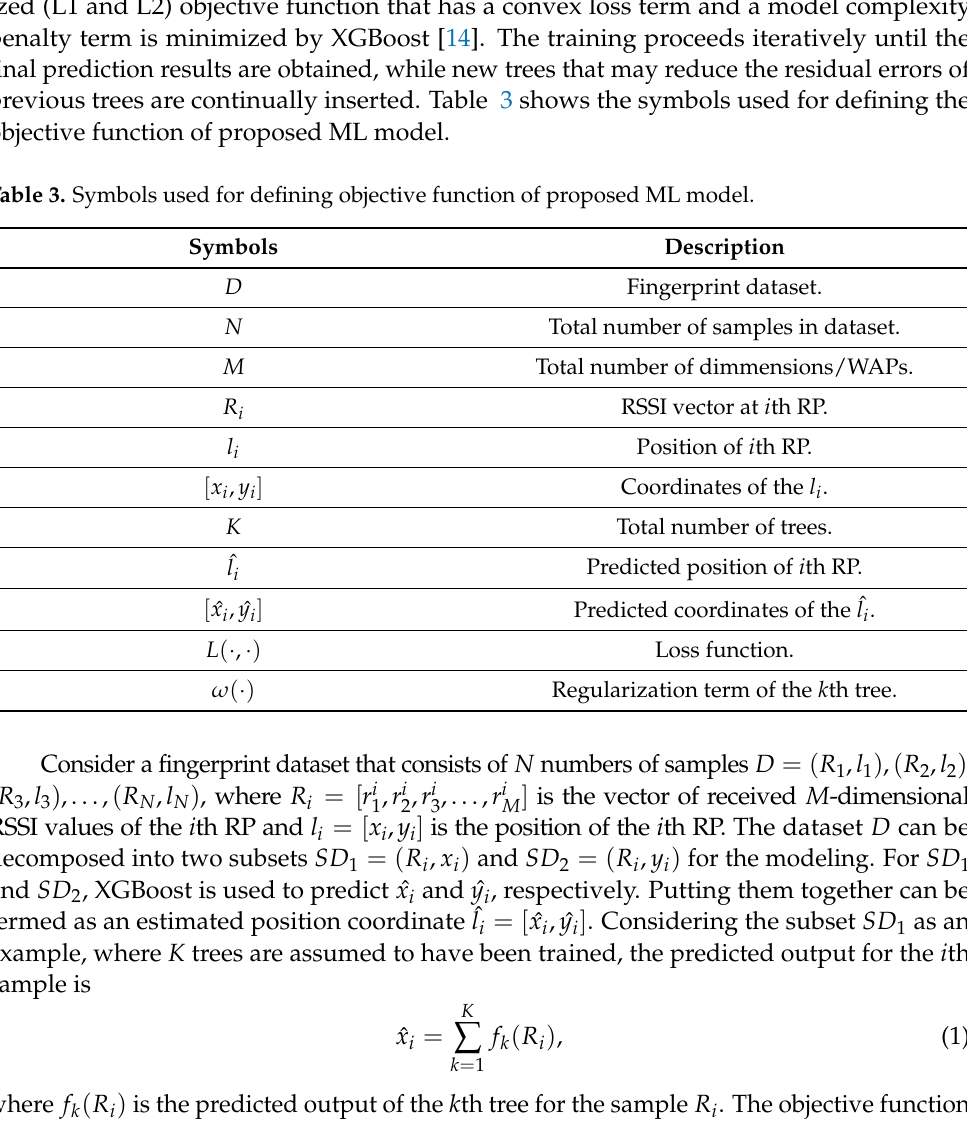
Table 3. Symbols used for defining objective function of proposed ML model. Symbols Description D Fingerprint dataset. N Total number of samples in dataset. M Total number of dimmensions/WAPs. R i RSSI vector at i th RP. l i Position of i th RP. [ x ] Coordinates of the l i , y i K Total number of trees. ˆ l i Predicted position of i th RP. [ ˆ x ] Predicted coordinates of the ˆ l i , ˆ y i L ( · , · ) Loss function. ω ( · ) Regularization term of the k th